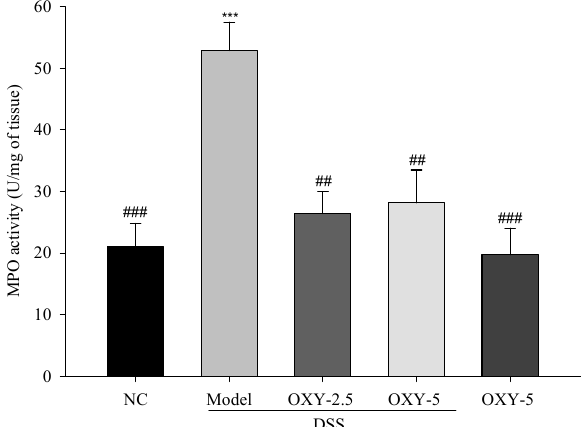
Figure 4. The effect of OXY on myeloperoxidase (MPO) activity ( n = 8/group). MPO activity in colon tissue was measured and normalized to colon fraction weight. NC, normal control group; model, DSS-induced colitis model group; DSS + OXY-2.5, DSS-induced colitis rats treated with OXY (2.5 mg/kg) group; DSS + OXY-5, DSS-induced colitis rats treated with OXY (5 mg/kg) group; OXY-5, rats treated with OXY (5 mg/kg) alone group. The values are expressed as mean ± SEM. Significant differences among groups were evaluated via ANOVA with Tukey’s post hoc HSD. *** p < 0.001 compared with the NC group; ## p < 0.01 and ### p < 0.001 compared with the model